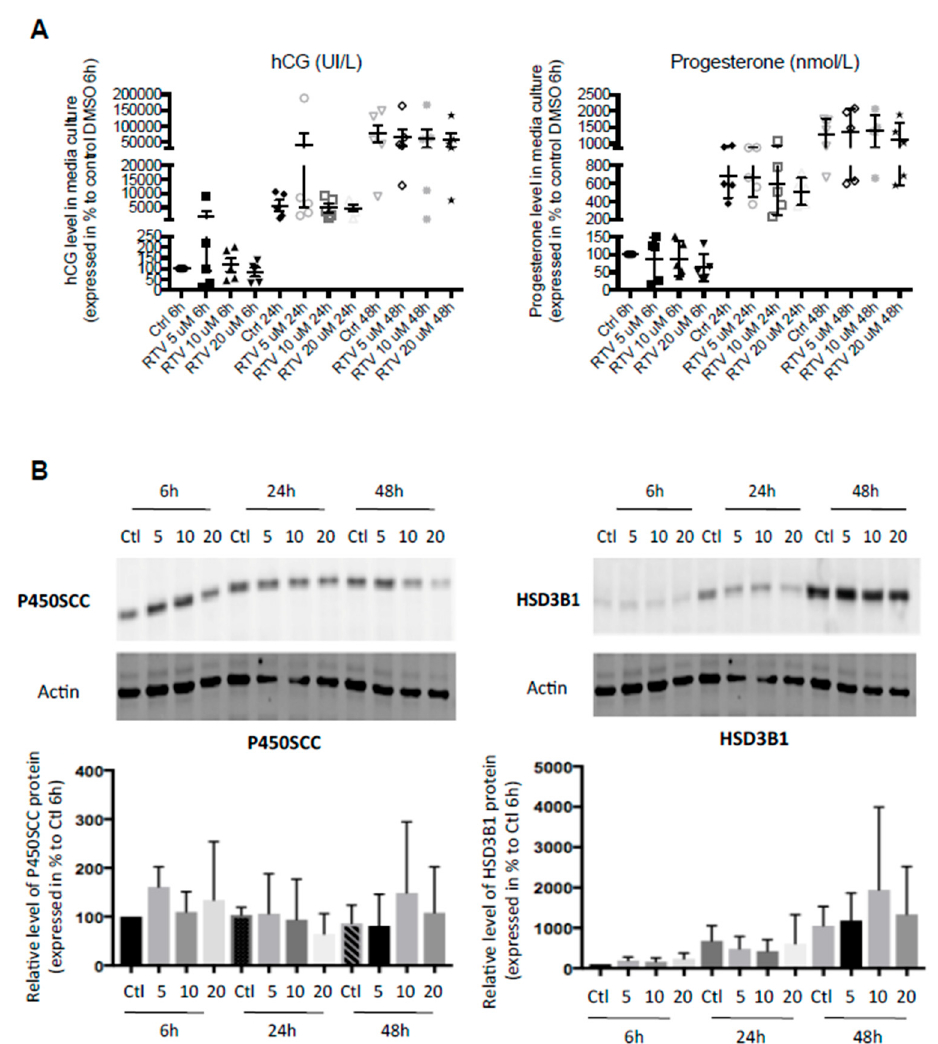
Figure 1. Ritonavir has no effect on hCG and P4 production during trophoblast differentiation. Cytotrophoblasts isolated and purified from term placenta were cultured for 15 h and then incubated with RTV at 5, 10 or 20 µ M or DMSO for 6 h, 24 h or 48 h to allow fusion process. ( A ) hCG concentration and P4 concentration were measured by immuno-analysis in culture supernatant. ( B ) The protein expression of P450SCC and HSD3B1 were evaluated using immunoblotting with anti-P450SCC and anti-HSD3B1 antibodies. The protein expression of actin was determined with anti-actin antibody, used as a loading control. The lanes intensity was measured with ImageJ program. Results are expressed as the mean +/ − SEM of n = 6 independent experiments. Two-tailed paired no parametric student t-tests were performed to compare RTV to DMSO exposition at the same incubation time.